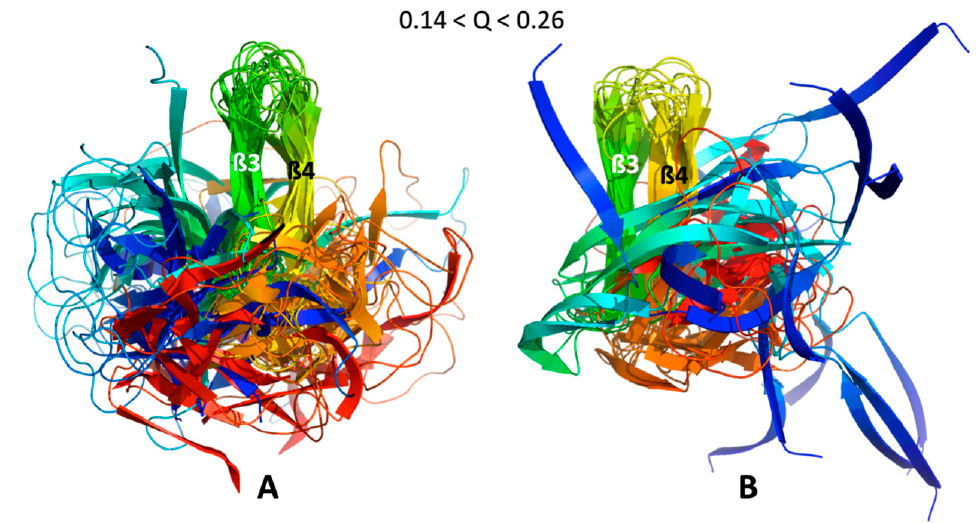
Figure 7. ß3ß4 folding intermediates. Cartoon Superimposition of the conformer centroids in most populated clusters selected to build the videos given in the Supplementary Materials (Videos S1 and S2), for ( A ) AVR-Pia and ( B ) AVR-Pib. Conformers centroids within the range 0.14 < Q < 0.26 are in rainbow colors from N-ter (blue) to C-ter (red) and the strands ß3 (green) and ß4 (yellow) are la- belled.